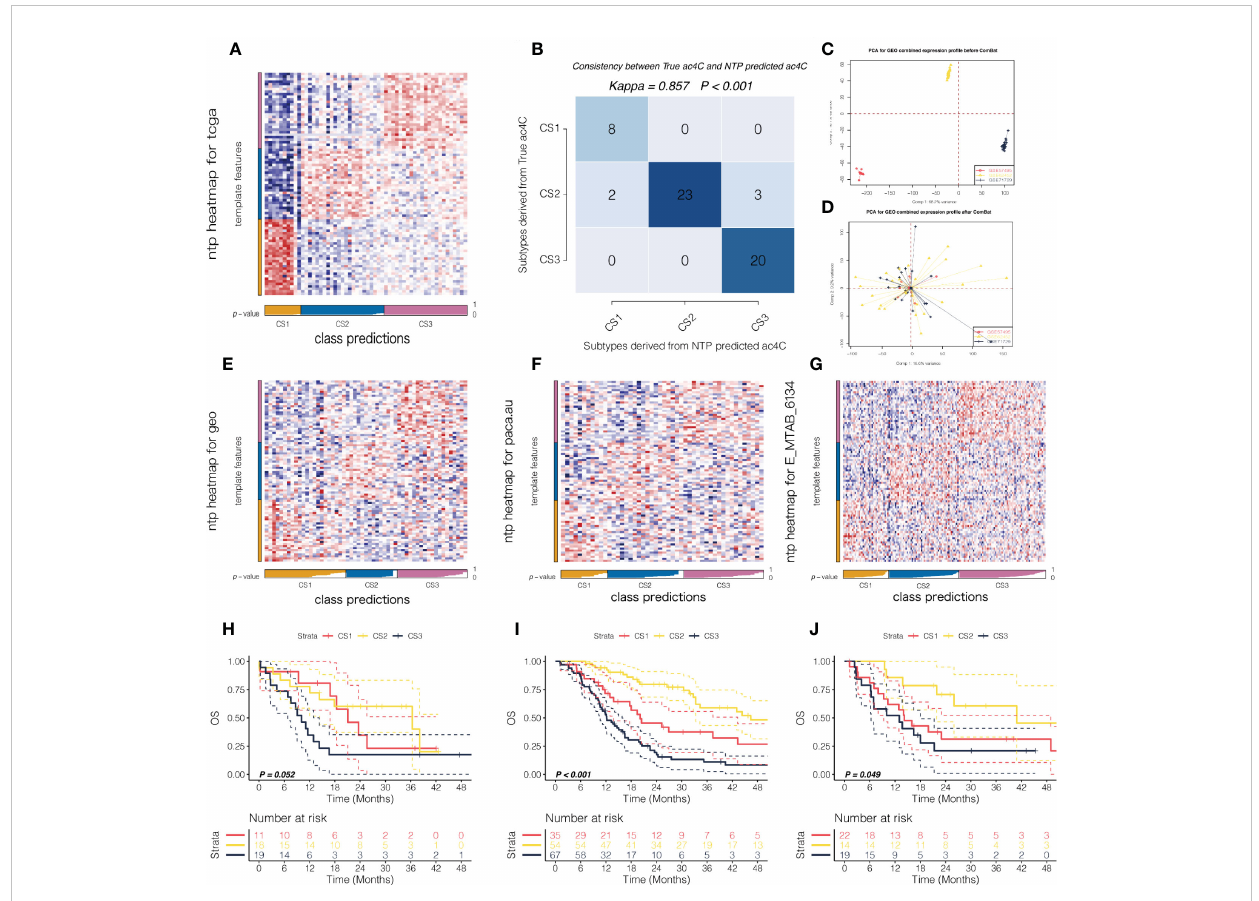
FIGURE 2 External validation of the prognostic subtypes in PDAC. (A) Heatmap showing the NTP results using 88-gene classi fi er in TCGA cohort. (B) Consistency map showing high agreement between true subtype and predicted subtype in TCGA cohort. PCA plot showing the potential batch effect (C) before and (D) after removal. NTP heatmap using 88-gene classi fi er was shown in (E) for GEO cohort, and the corresponding survival curves regarding OS were shown in (F) . Likewise, NTP heatmap using 88-gene classi fi er was shown in (G) for PACA_AU cohort and (H) for E-MTAB-6134 cohort, respectively. The corresponding survival curves regarding OS were shown in (I) for PACA_AU cohort and (J) for E-MTAB-6134 cohort,